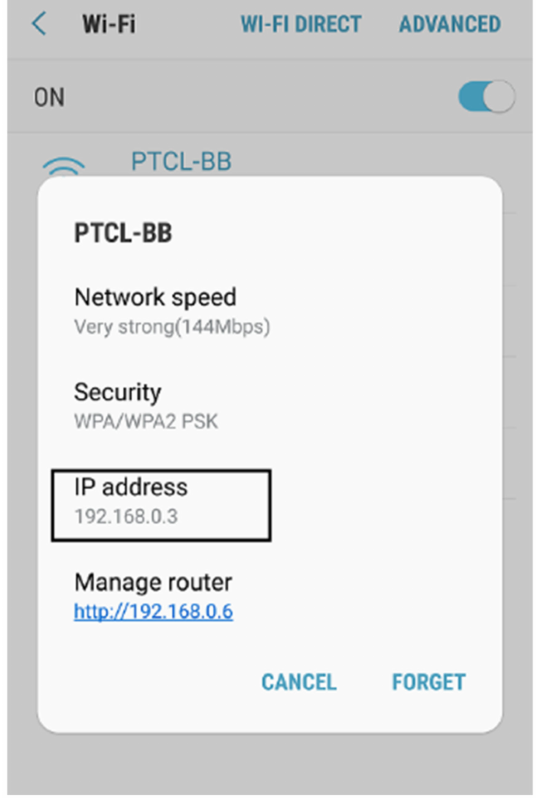
Figure 4. A screenshot of a smartphone IP